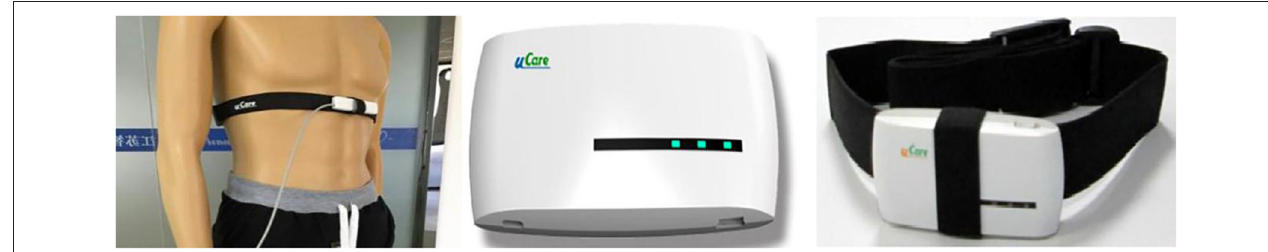
FIGURE 2 | The wearable hardware device used to collect ECG and respiration signals.